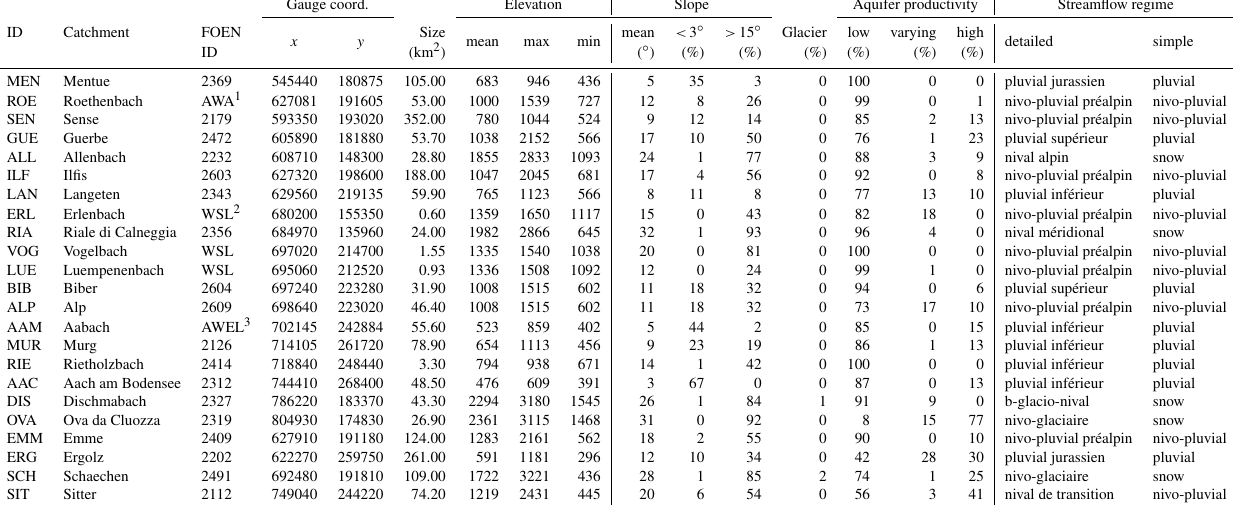
Table 1. Catchment characteristics: ID is the identification number that is used throughout the paper. FOEN ID is the identification number that is used by the Swiss Federal Office of the Environment (FOEN); if there is no FOEN ID, the station is maintained on a cantonal level or by the WSL and indicated with the acronym of the respective organization. Gauge coordinates are given using the official Swiss reference system: CH1903 + . Aquifer productivity is given as relative catchment area with low, varying and high productivity (Bitterli et al., 2004). Gauge